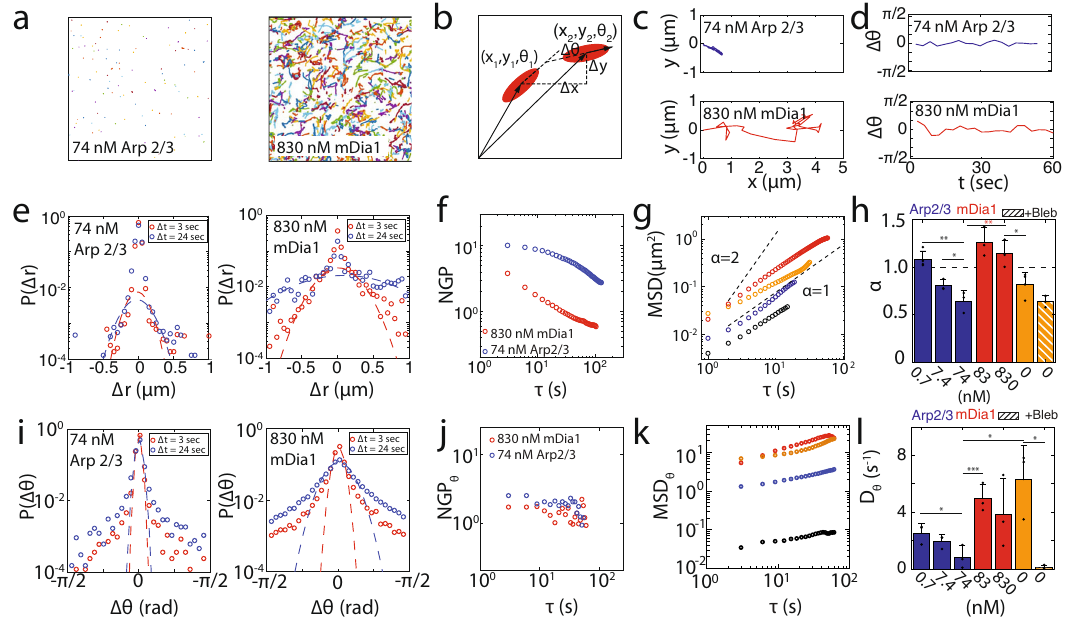
Fig. 5 | F-actin branching inhibits translational and rotational diffusion of myosin thick fi laments. Trajectories of myosin thick fi laments over 1min within a 74nM Arp2/3 and 830nM mDia1-nucleated F-actin networks. b A schematic for measuring translational and rotational motion of a myosin thick fi lament between two time points. c , d Individual translational and rotational trajectories of myosin thick fi laments. Van Hove relationship e and Non-Gaussian Parameter f for trans- lational displacement of 74nM Arp2/3 and 830nM mDia1-nucleated networks at both 3 and 24s. g Translational Mean-Square Displacement (MSD) of thick fi la- ments.Red:830nMmDia1.Orange:Non-nucleatednetwork.Blue:0.74nMArp2/3. Black: Non-nucleated network with blebbistatin. h Slope α of the MSD for all con- ditions. (* p <0.05, ** p <0.01. p (74nM Arp & 830 mDia1) = 0.0089, p (74nM Arp &